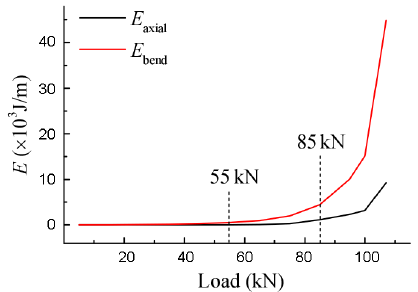
Figure 8. The E axial -load and E bend -load curves of arch